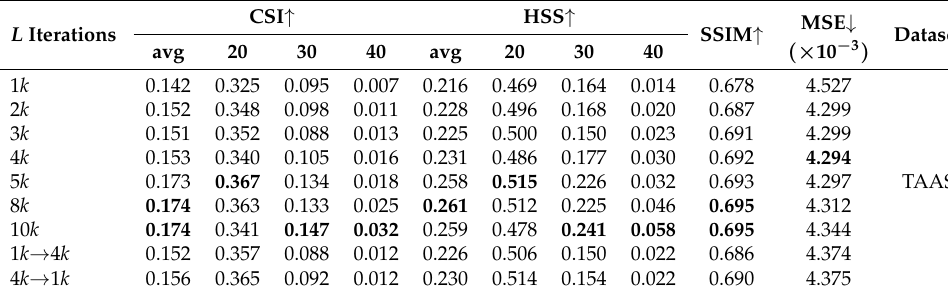
Figure 6. TSS strategies with different L . t stands for the number of frames for training in Algorithm 2. Table 6. The TSS strategy with different L on